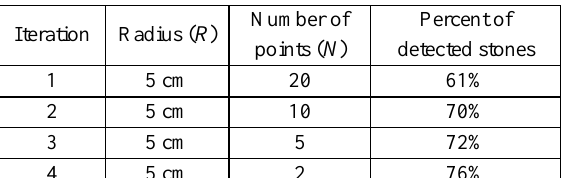
Figure 5. Two first iterations of the proposed algorithm